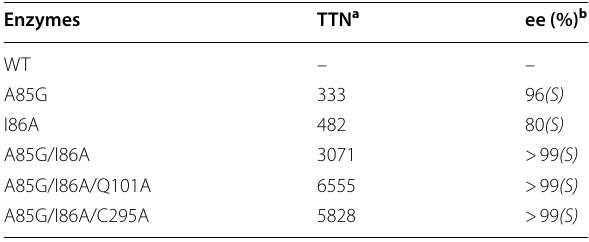
Table 3 Total turnover numbers (TTNs) of mutants in the reduction of ketone 1